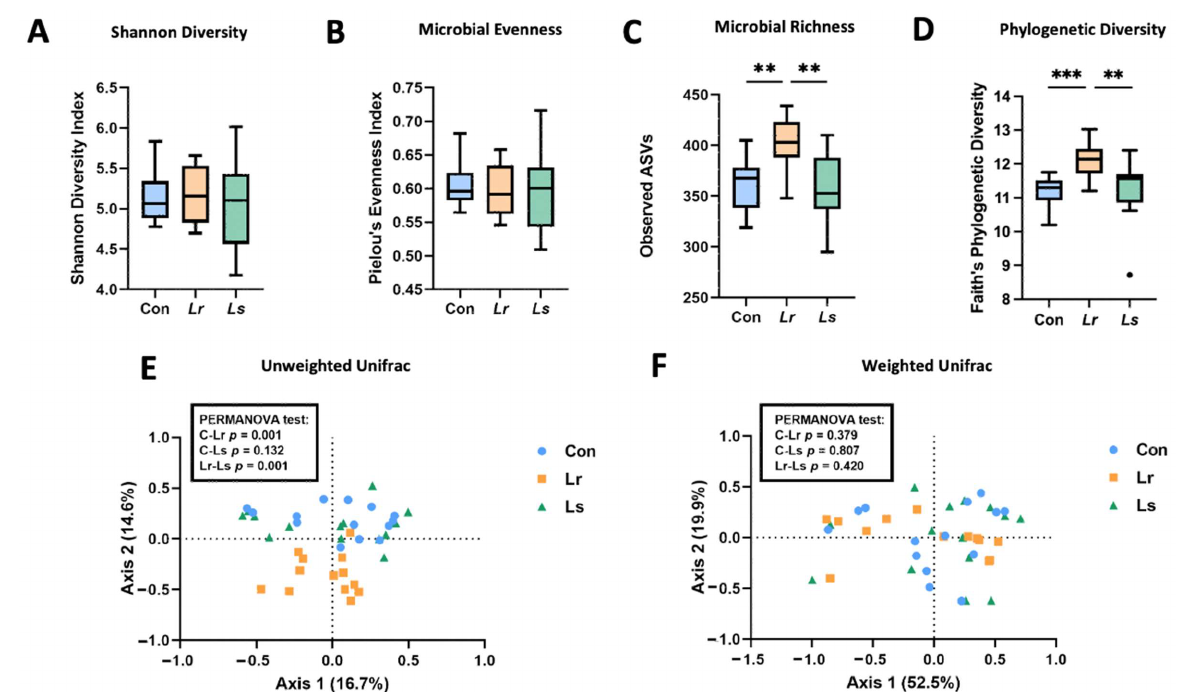
Figure 2. α- and β-diversity metrics of fecal microbiota following probiotic treatment. ( A – D ) Microbial richness, evenness, and phylogenetic diversity as measured by various α-diversity parameters (i.e., Shannon Diversity ( A ), Pielou’s Evenness ( B ), Observed ASVs ( C ), and Faith’s Phylogenetic Diversity ( D ) indices). ( E , F ) Principal Coordinate Analysis (PCoA) plot of unweighted and weighted Unifrac distances as a measure of microbial community structure. N = 13–14 mice/group. Con—Control; Lr — L. rhamnosus HA-114; Ls — L. salivarius HA-118. Boxes extend from the 25th to 75th percentiles with the whiskers representing the furthest point that is within 1.5 times the IQR. ** p < 0.01, *** p < 0.001.